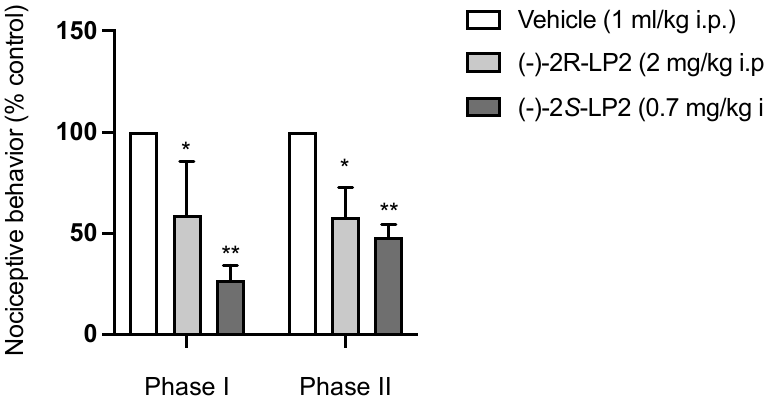
Figure 2. ( − )-2 S -LP2 decreased nociceptive behaviour in the mouse formalin test. Intraperitoneal administration of ( − )-2 S -LP2 (0.7 mg/kg) and ( − )-2 R -LP2 (2 mg/kg) were able to reduce nociceptive behaviour in both phases of the formalin test. Results are expressed as mean ± SEM ( n = 6–8 mice per group) and are represented as the percentage of inhibition of pain responses of the respective vehicle group (100%). * p < 0.05, ** p < 0.01 vs. Vehicle, two-way ANOVA followed by Bonferroni post-hoc test.